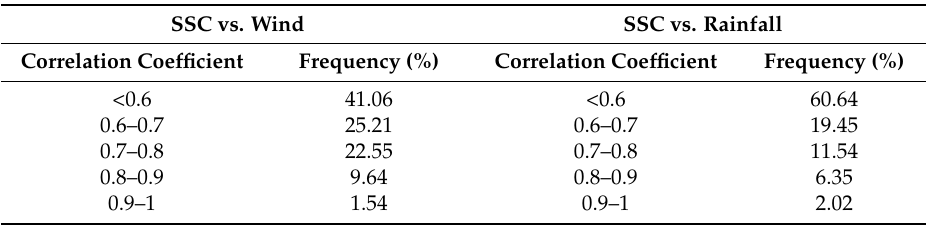
Table 3. Cross-correlation results between suspended sediment concentration (SSC) and wind, SSC, and rainfall.